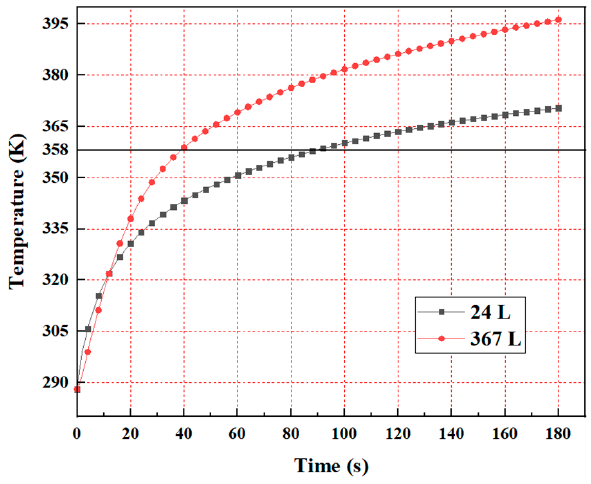
Figure 13. Evolution of the hydrogen temperature rise for di ff erent cylinder volumes.